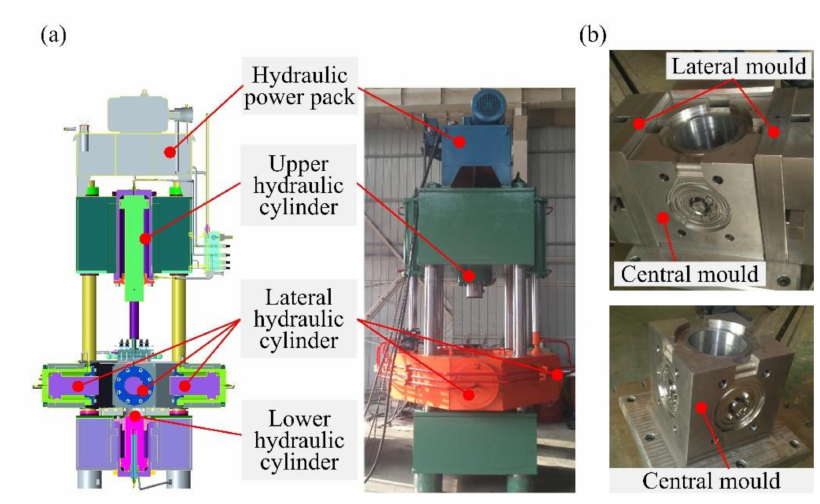
Figure 3. ( a ) The multicavity squeeze casting hydraulic press and ( b ) the multidirection squeeze forming mold for manufacturing scrolls.